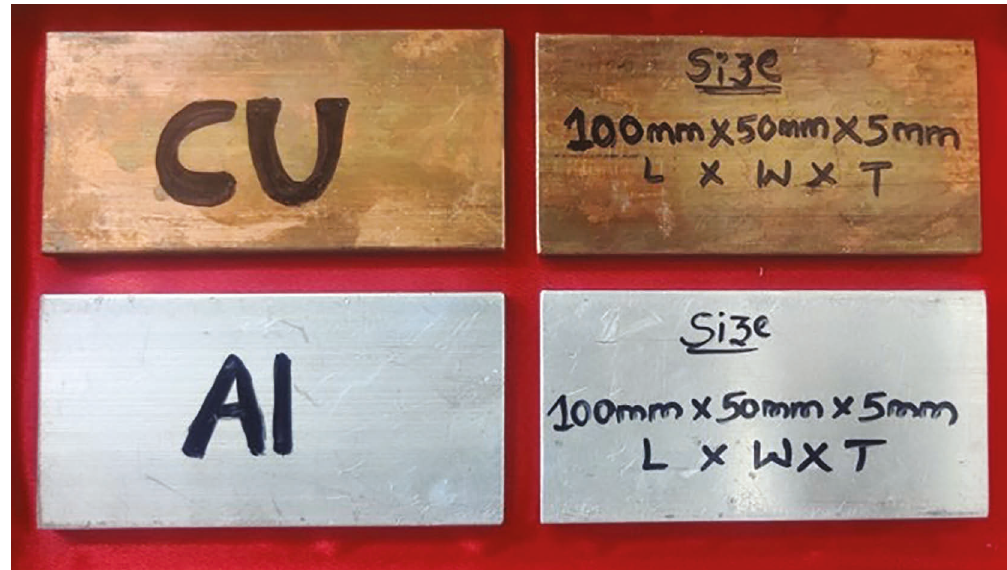
Figure 4: Crafted plates of C11000 and